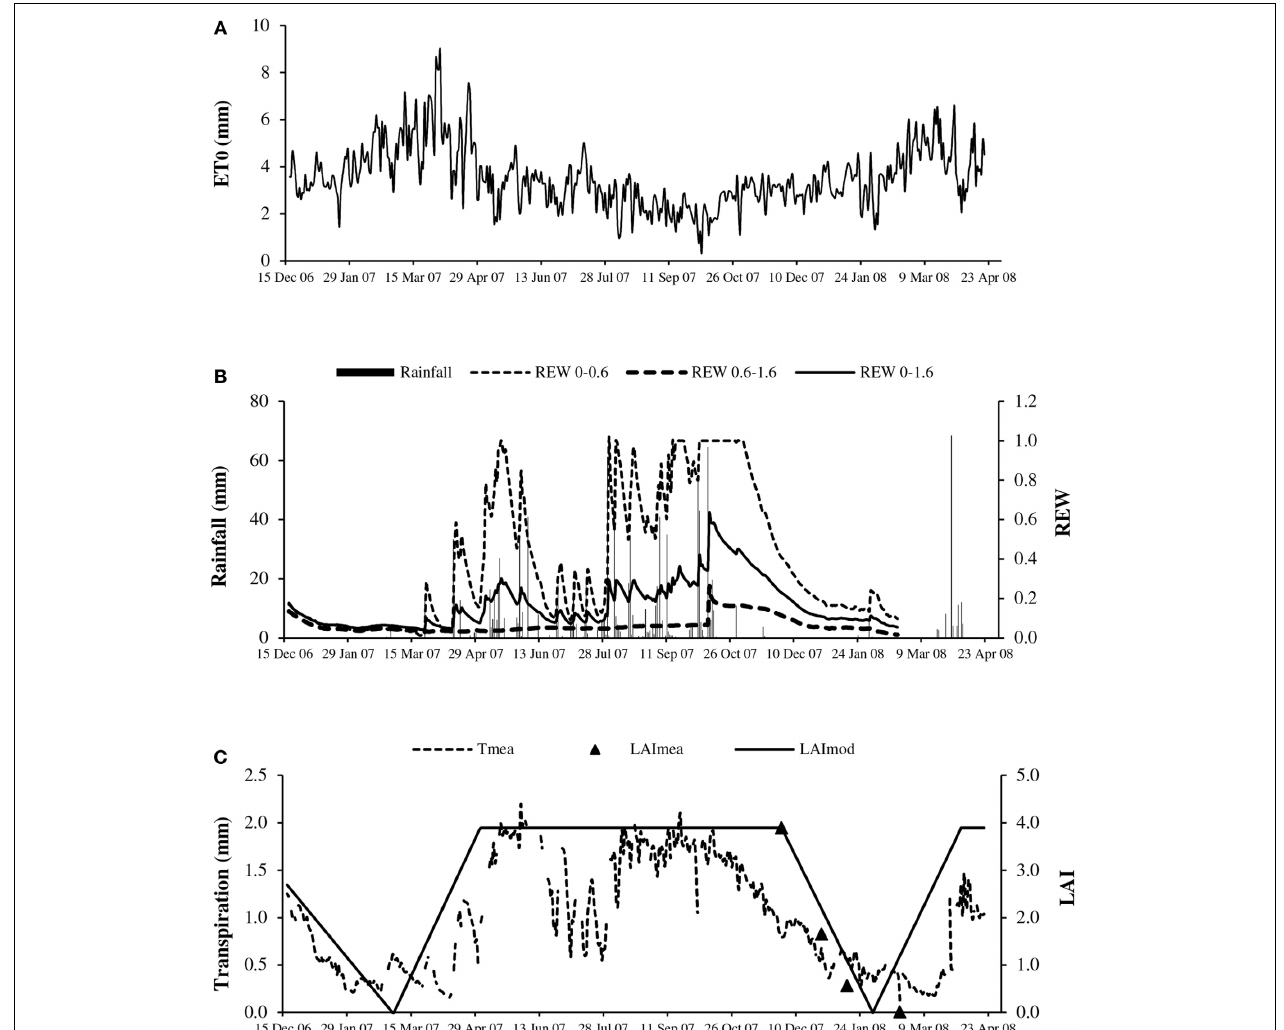
FIGURE 1 | Seasonal course of: (A) reference evapotranspiration ( ET0 ); (B) rainfall (solid bar) and relative extractable water of bulk soil ( REW ) for layers 0–0.6m ( REW 0–0.6), 0.6–1.6m ( REW 0.6–1.6) and 0–1.6m